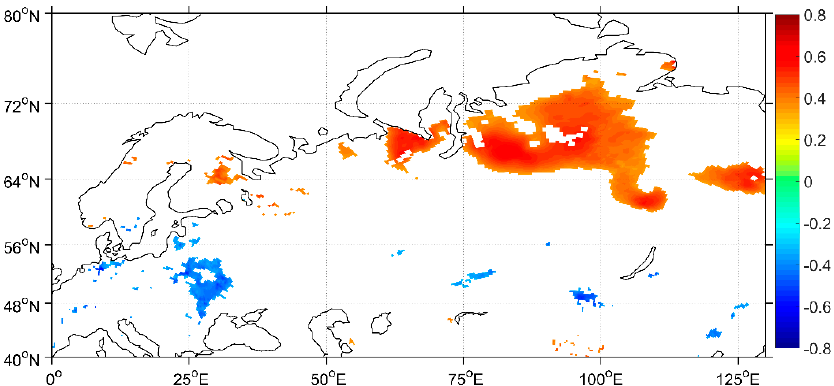
Figure 5. The correlation coefficient distribution between winter snow water equivalent in Eurasia and the Barents–Karas Sea ice concentration index. The colored regions passed the t-test with a confidence level of 95%. All of the series have been detrended.